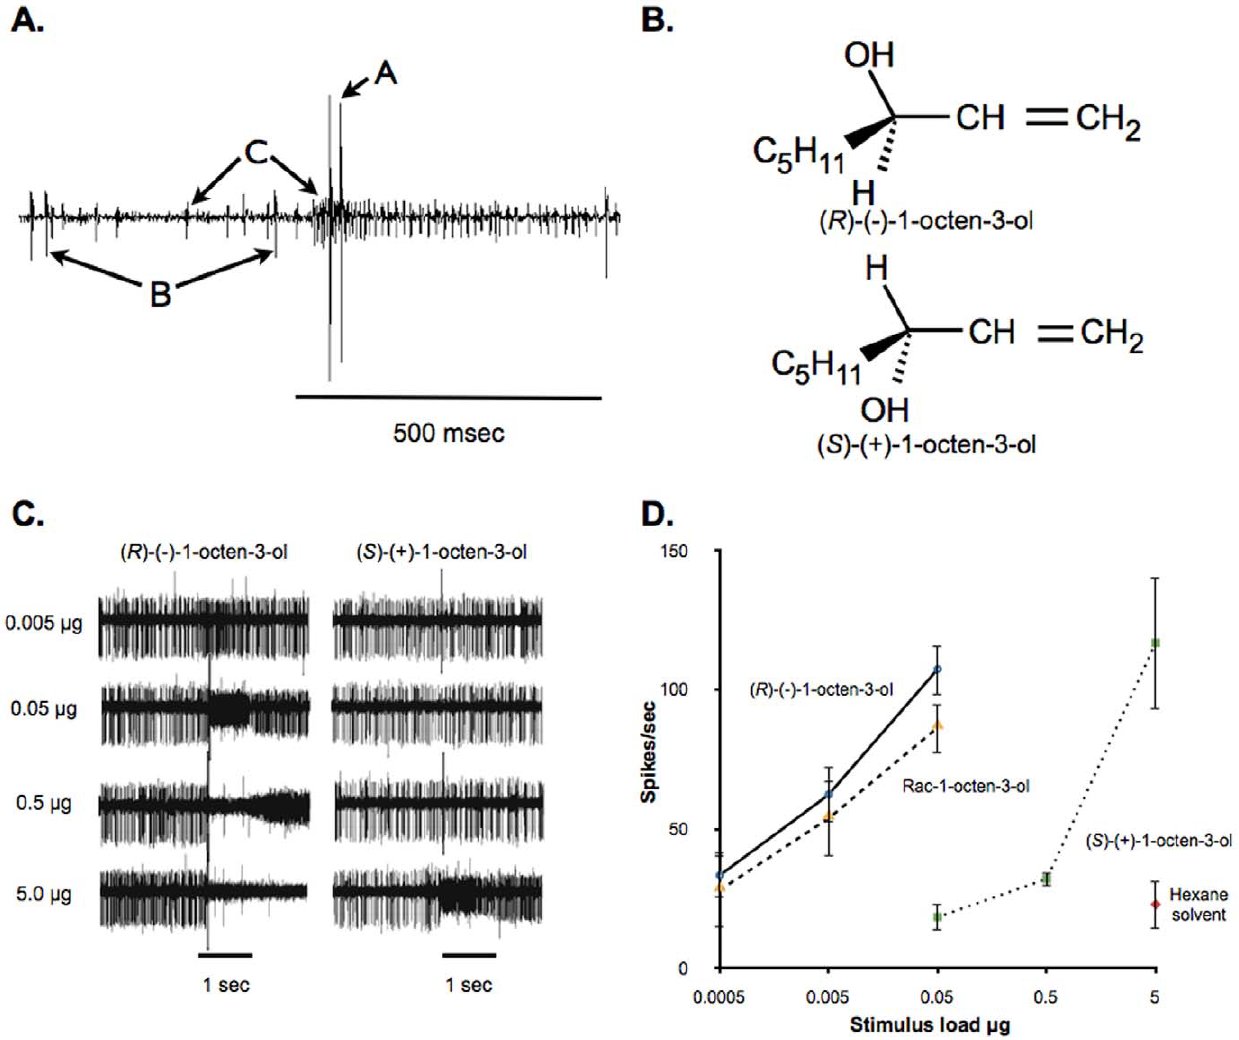
Figure 1. Chiral selectivity of the ‘‘C’’ neuron of maxillary palp basiconic sensilla. (A) Spontaneous activity of neurons associated with a basiconic sensillum on the maxillary palp of a female Ae. aegypti . Note the presence of three spike heights: A=largest spike is responsive to CO 2 , B=intermediate spike, and C=smallest amplitude spike is reliably activated by ( R )-( 2 )-1-octen-3-ol. Response of ‘‘C’’ neuron is to a low dose of ( R )- ( 2 )-1-octen-3-ol. (B) Structure of enantiomers of 1-octen-3-ol: ( R )-( 2 )-1-octen-3-ol and ( S )-( + )-1-octen-3-ol. (C) Electrophysiological responses from an individual basiconic sensillum to a 1 sec exposure to increasing stimulus loads of the enantiomers of 1-octen-3-ol. Note at higher loads of ( R )-( 2 )-1- octen-3-ol spikes from ‘‘C’’ neuron are not easily discerned from baseline. (D) Dose-response curves constructed from mean responses of ‘‘C’’ neurons to increasing stimulus loads of racemic 1-octen-3-ol (Rac-1-octen-3-ol, n=4)), and its component enantiomers, ( R )-( 2 )-1-octen-3-ol (n=5), and ( S )-( + )- 1-octen-3-ol (n=4). Points represented are mean 6